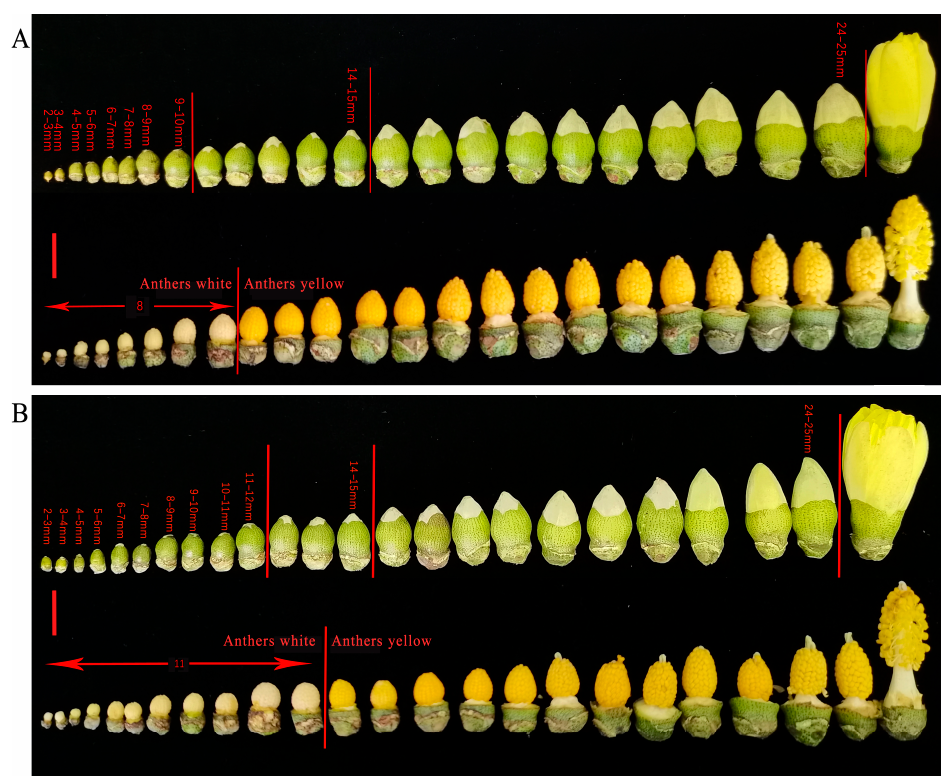
Figure 3. The effect of glyphosate on buds and anthers. ( A ) Developmental dynamics of buds and anthers treated with water; ( B ) developmental dynamics of buds and anthers treated with 15 g/L glyphosate. The scale bar is 1 cm.